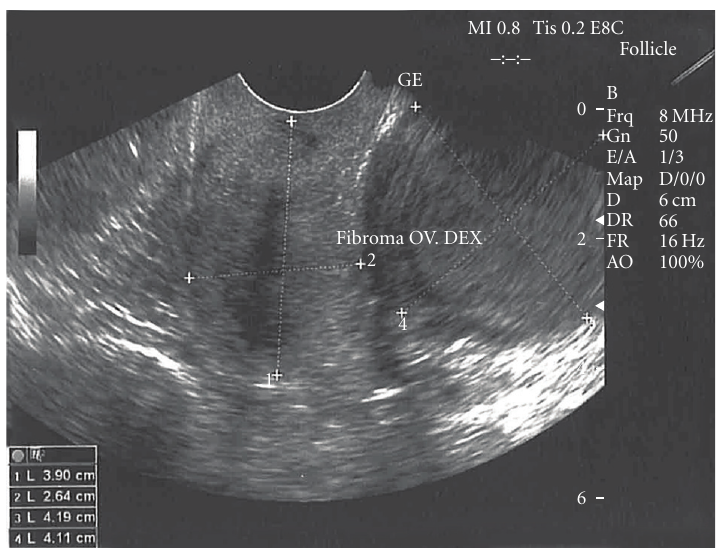
Figure 1: Intravaginal ultrasonography shows a 3.9mm cyst mass in the right lower abdominal quadrant.